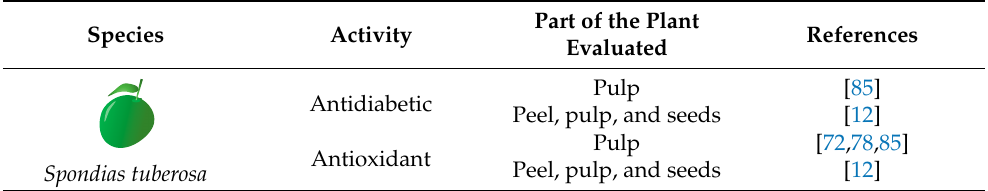
Table 4. Summary of Spondias tuberosa activity in different parts of the plant, as described in the last few